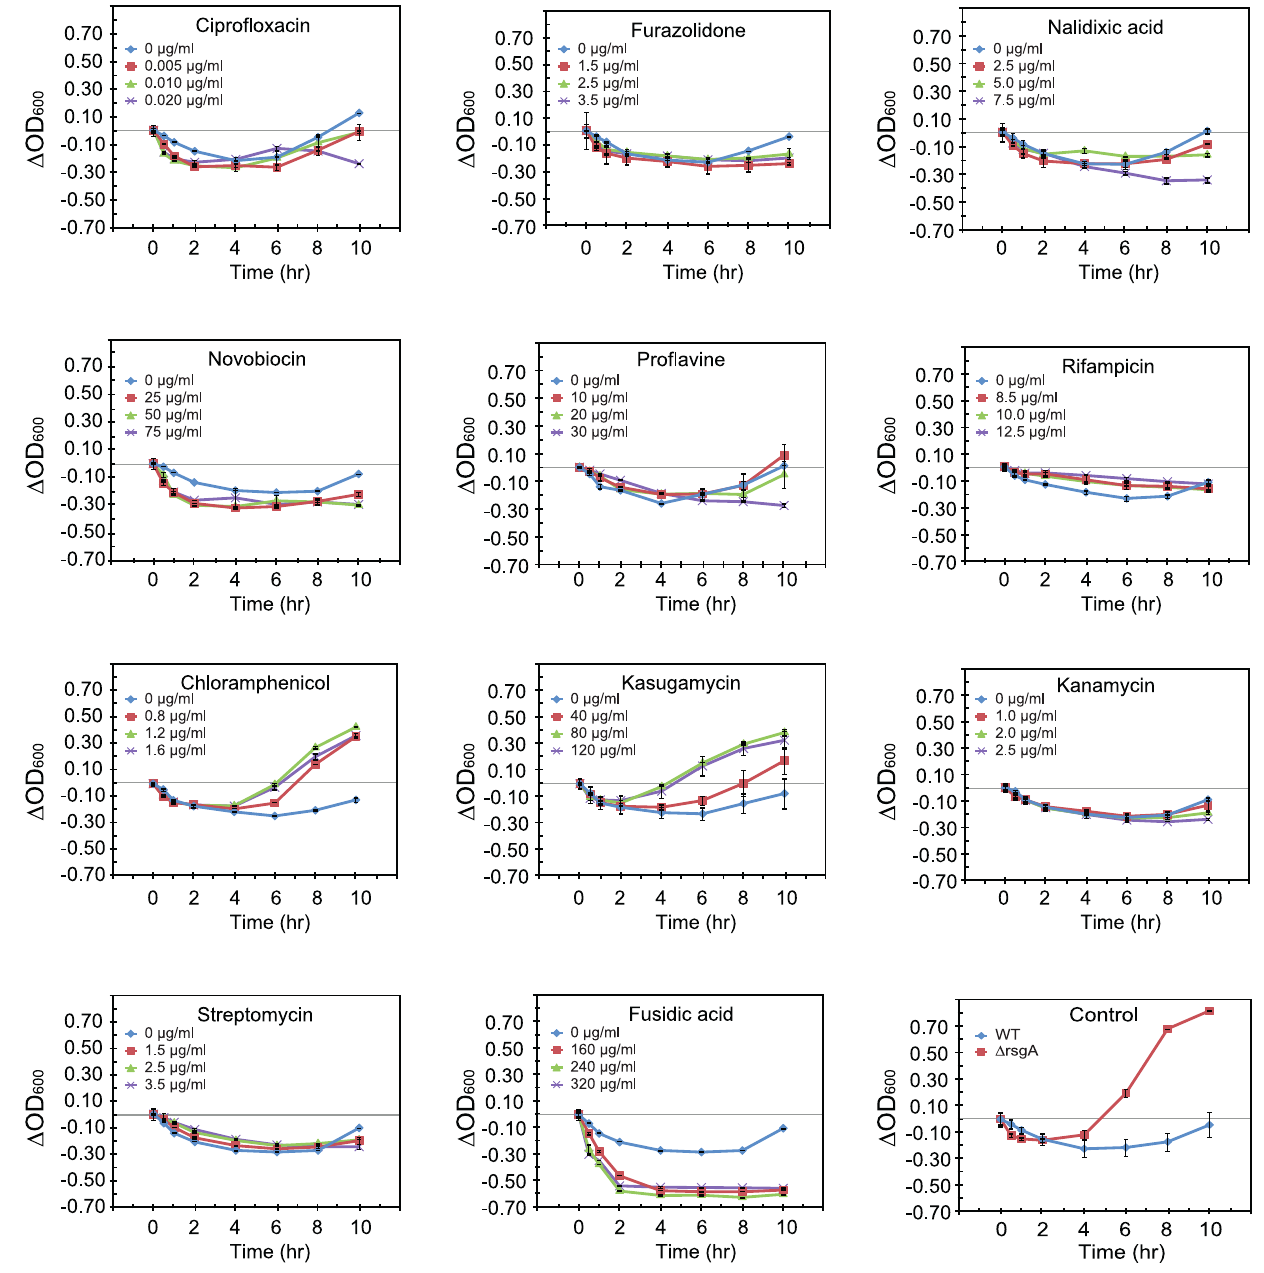
Figure 2. Effects of inhibitors of DNA synthesis, transcription and translation on salt tolerance. Wild type cells were grown at 37 u C in LB medium with the indicated concentration of each drug. When OD 600 reached 0.8, 0.9 M NaCl was added to the medium. Three different concentrations for each antibiotic, which were determined in consideration of the inhibitory effect on the growth of wild type cells in LB medium in the absence of salt shock, were used (Table S1). Growth of drug-untreated n rsgA cells is shown as the